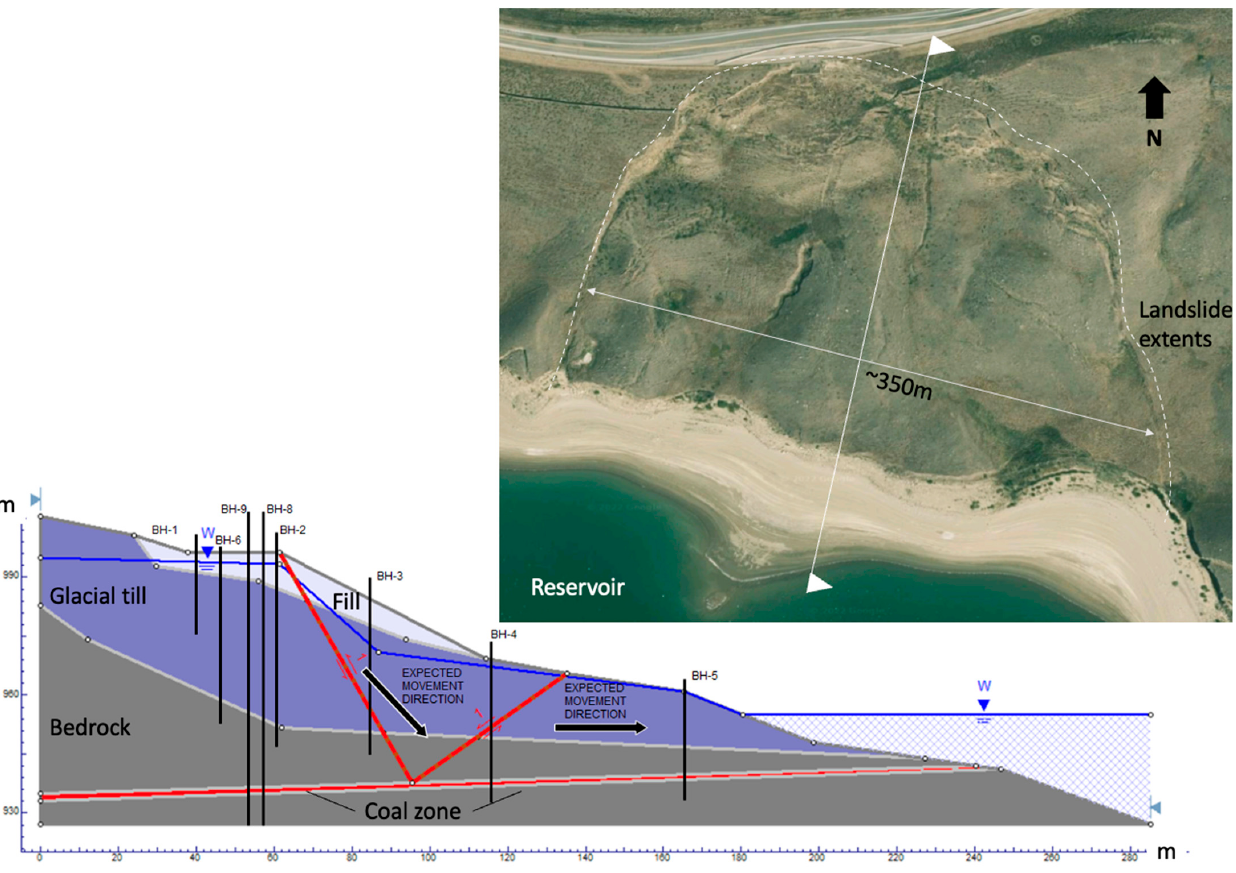
Figure 6. Chin Coulee landslide kinematics. Oblique red lines represent the boundaries of the active and passive wedges; the basal rupture surface is moving through the weak coal material as interpreted in [34] (base imagery from Google © Maxar Technologies 2022).